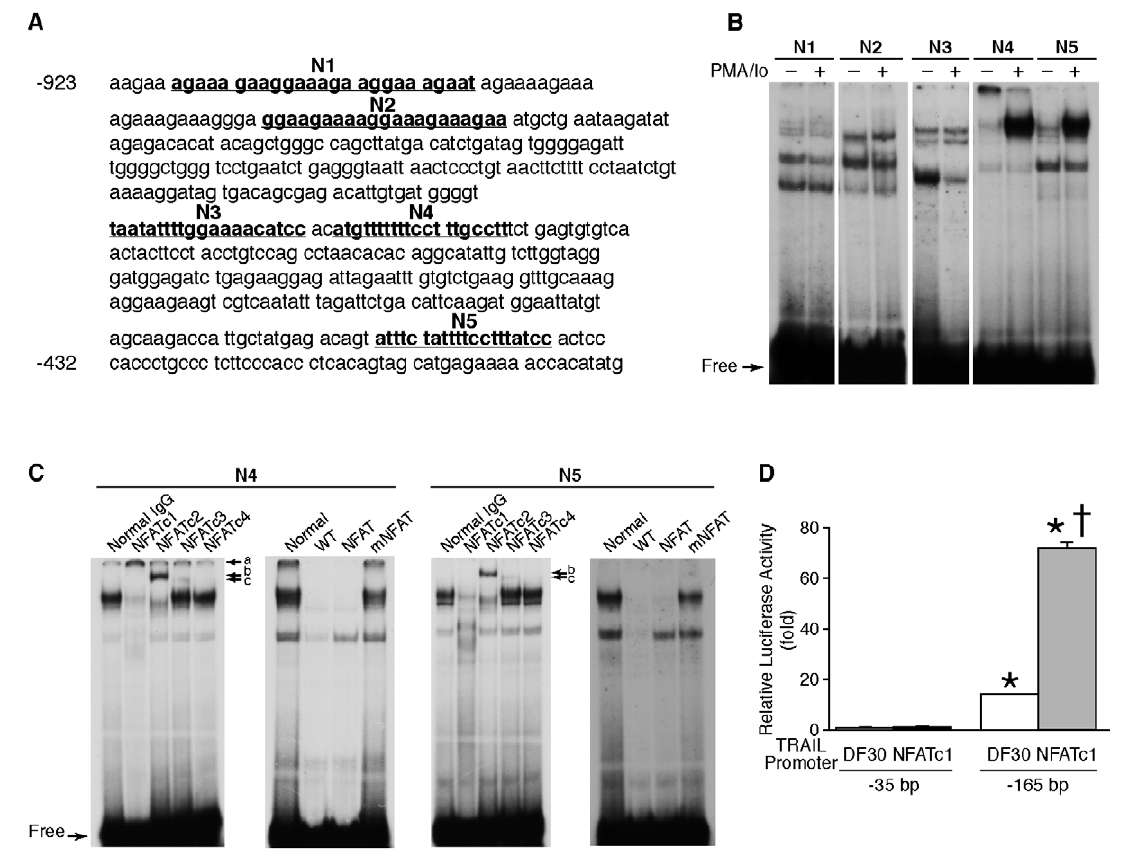
Figure 4. Deletion of NFAT binding sites did not eliminate NFATc1 increased TRAIL promoter activity. ( A ) Nucleotide sequences of the putative NFAT binding sites in the human TRAIL promotor. The 1371 bp TRAIL promoter contains five putative NFAT binding sites (N1, N2, N3, N4, and N5). The numbers on the left are the nucleotide positions relative to the transcriptional start site. ( B ) HT29 cells were treated with or without PMA/Io for 60 min and nuclear protein extracted; EMSA was performed with 32 P-labeled probes spanning each of the five NFAT binding sites (N1, N2, N3, N4, and N5) in the human TRAIL promoter. ( C ) Specific binding of various NFAT isoforms with probe N4 or N5 was determined by addition of antibodies to either NFATc1, NFATc2, NFATc3, or NFATc4. Specific binding of NFAT was also confirmed by cold competition using unlabeled wild type (WT) and mutant probes at 100-fold molar excess. ( D ) Caco-2 cells were transfected with constructs containing 2 35 or 2 165 TRAIL promoter sequences together with either control plasmid pDF30, or Flag-tagged NFATc1, respectively. At 48 h posttransfection, cells were harvested; and luciferase activity was assayed. All results were normalized for transfection efficiency using the pRL-Tk-luc plasmid (Promega). (Data shown as mean 6 standard error of the mean; *, P , 0.05, DF30 or NFATc1 plus 2 165 bp promoter vs. DF30 or NFATc1 plus 2 35 promoter, respectively; + , P , 0.05, DF30 plus 2 165 bp promoter vs. NFATc1 plus 2 165 bp promoter).